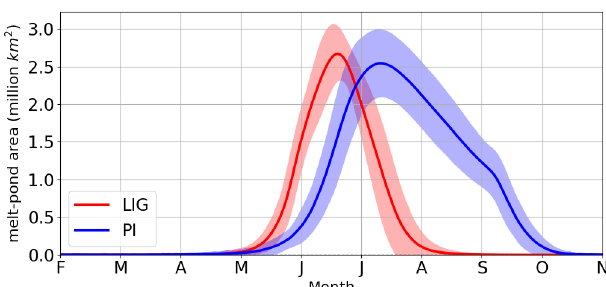
Figure 10. Annual cycle of Arctic melt pond area. The 200-year mean was computed from the daily model output variables grid-cell sea-ice area and melt pond area over the region from 70–90 ◦ N. The shaded area is plus or minus twice the standard deviation. Only ice- covered grid cells were